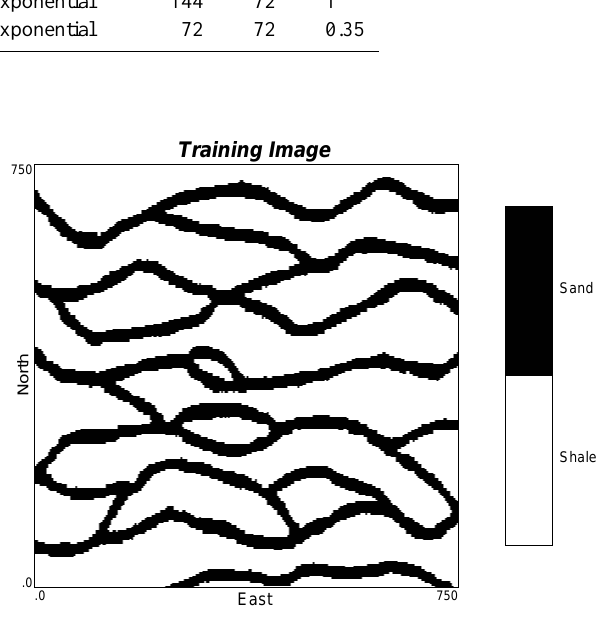
Fig. 1. Training image used to generate the facies distribution.